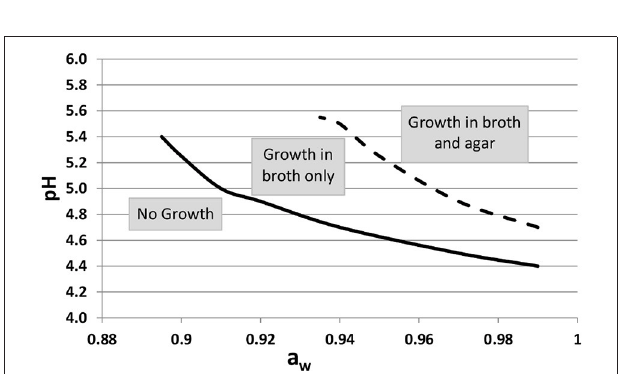
FIGURE 4 | Growth/No growth regions of Listeria monocytogenes in broth (solid line) and in agar (dotted line) medium at 25 ◦ C as a function of pH and a w , (modified by increasing the NaCl concentration). Adapted from Koutsoumanis et al.